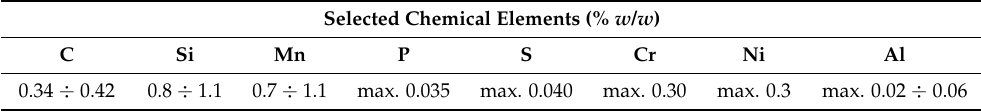
Table 3. The declared chemical composition of 38 GSA